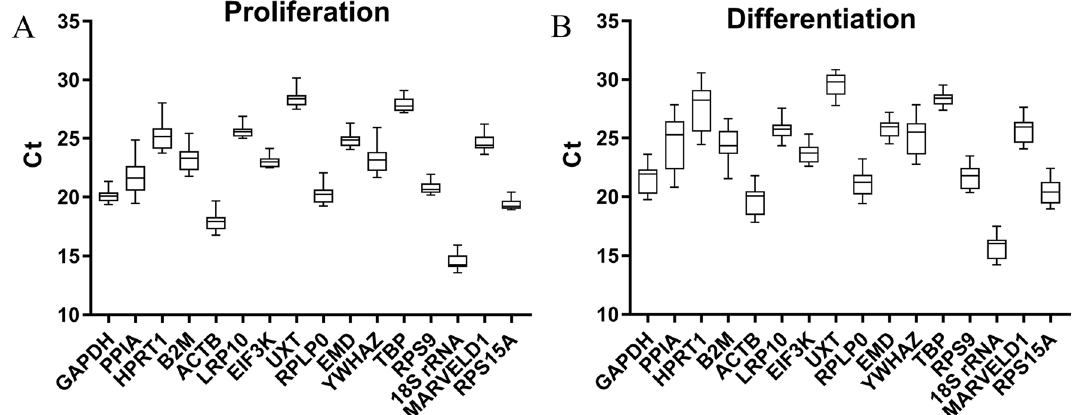
Figure 2. Ct value profiles of sixteen candidate reference genes in bovine SMSCs under two experimental conditions. ( A ) Ct values for proliferation. ( B ) Ct values for induced